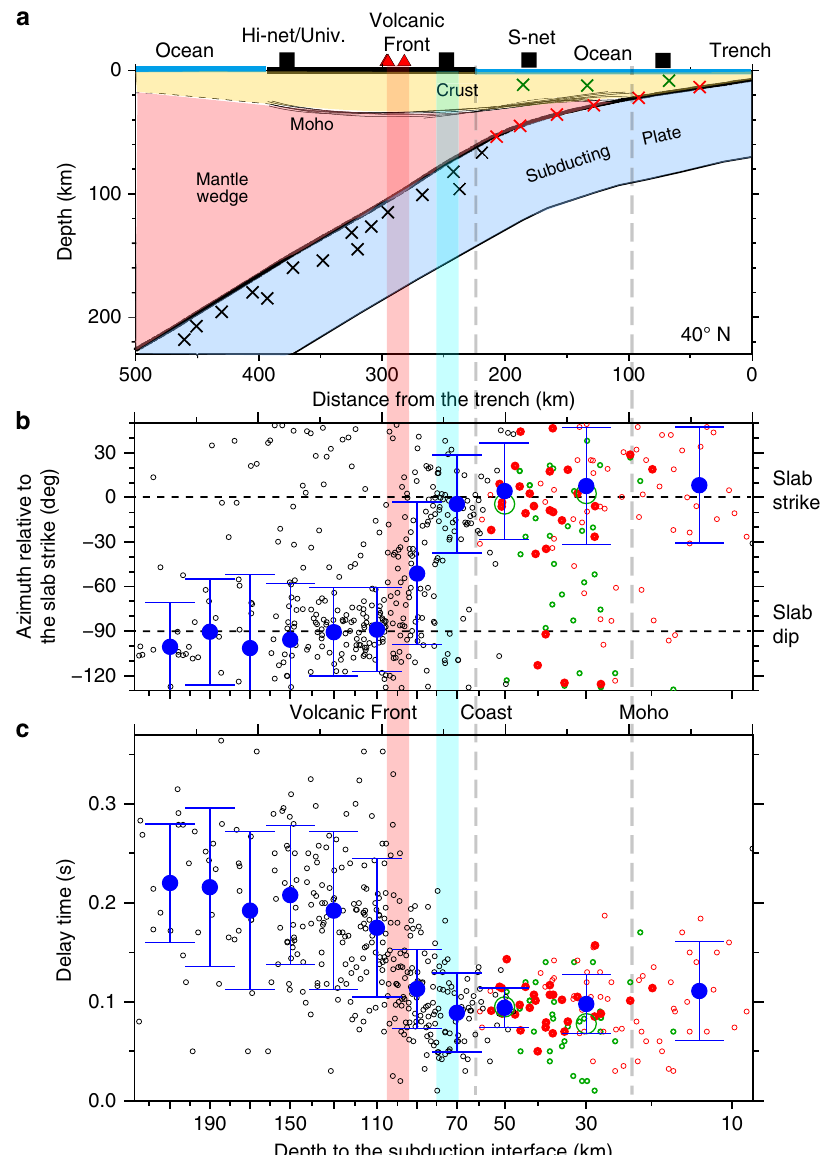
Fig. 3 Dependence of splitting parameters on the depths of interplate earthquake sources. ( a ) Geometry of subduction interface along a margin-normal pro fi le at 40°N [Modi fi ed from Uchida et al., 2010 50 ]. Crosses schematically show earthquakes, and black squares schematically show seismic stations that record shear waves from these events. ( b ) Azimuth of fast shear-wave polarization beneath each station measured clockwise from the strike direction of the Paci fi c slab. Note that an azimuth − 130° is the same as 50°. ( c ) Delay time between the fast and slow polarized waves. The depth axis is scaled to distance using the interface geometry shown in ( a ). In ( b ) and ( c ), red, green, and black circles show station averaged values based on interplate events, upper-plate events, and intraslab events, respectively. The intraslab data are from Nakajima et al. [2006] 17 . Filled red circles indicate the number of waveforms is larger than 10. Blue circles with error bars (one standard deviation) represent average values for events within every 20 km depth interval, except for the shallowest one which is an average from the 7 km trench depth to 20 km. For each depth average, we show the mean azimuth and circular standard deviation that utilize the azimuth and length of the summed unit vectors 53 . Blue and red vertical bars mark the maximum depth of slab-mantle decoupling 33 and the volcanic front,